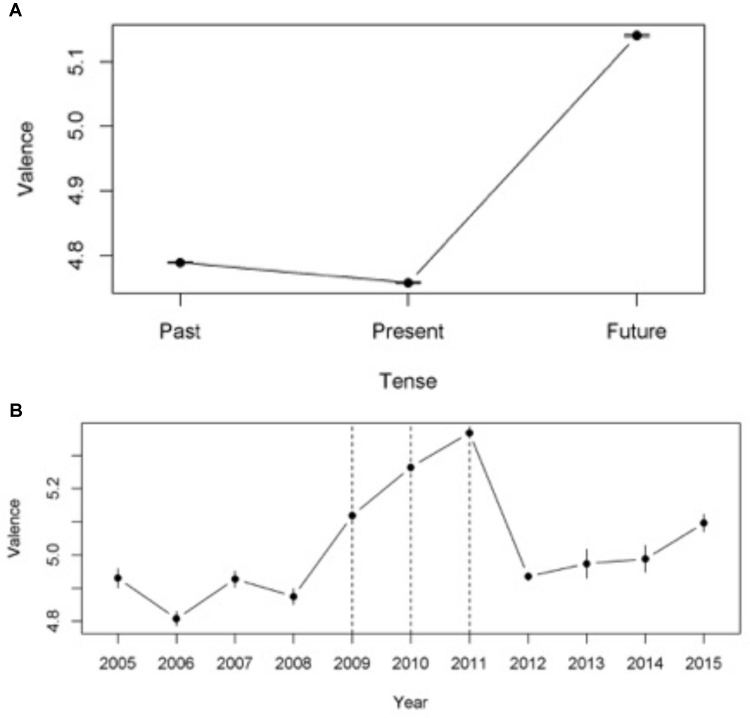
(A) Mean Valence and confidence intervals for Facebook Verbs in Past, Present, and Future tense. (B) Mean Valence and confidence intervals for Facebook Years. Dotted line marks the relative publication dates.